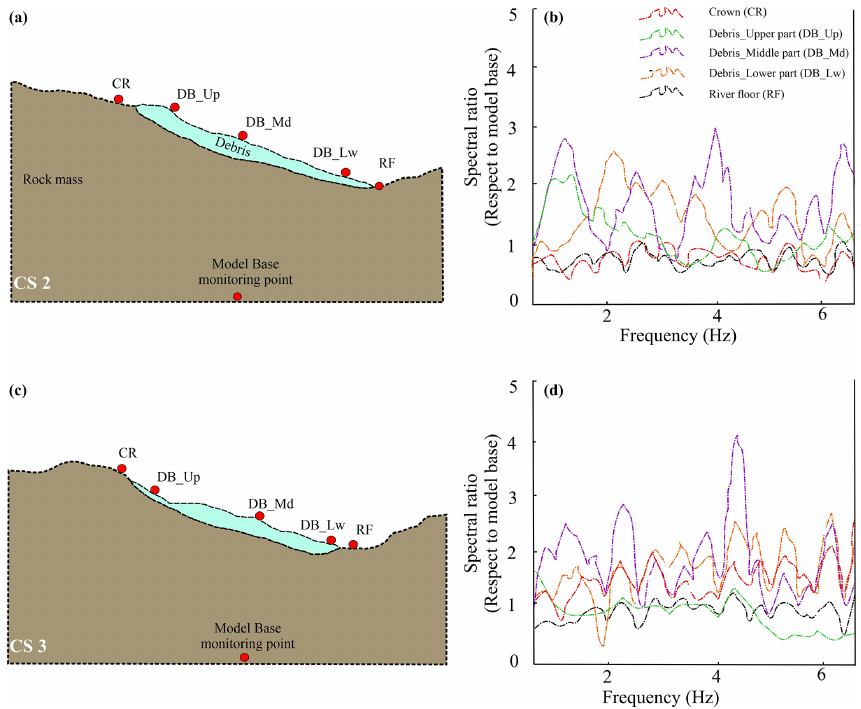
Figure 12. Spectral ratio pattern. (a) CS-2 model with the position of monitoring points. (b) Spectral ratio pattern in CS-2. (c) The CS-3 model with the position of monitoring points. (d) Spectral ratio pattern in